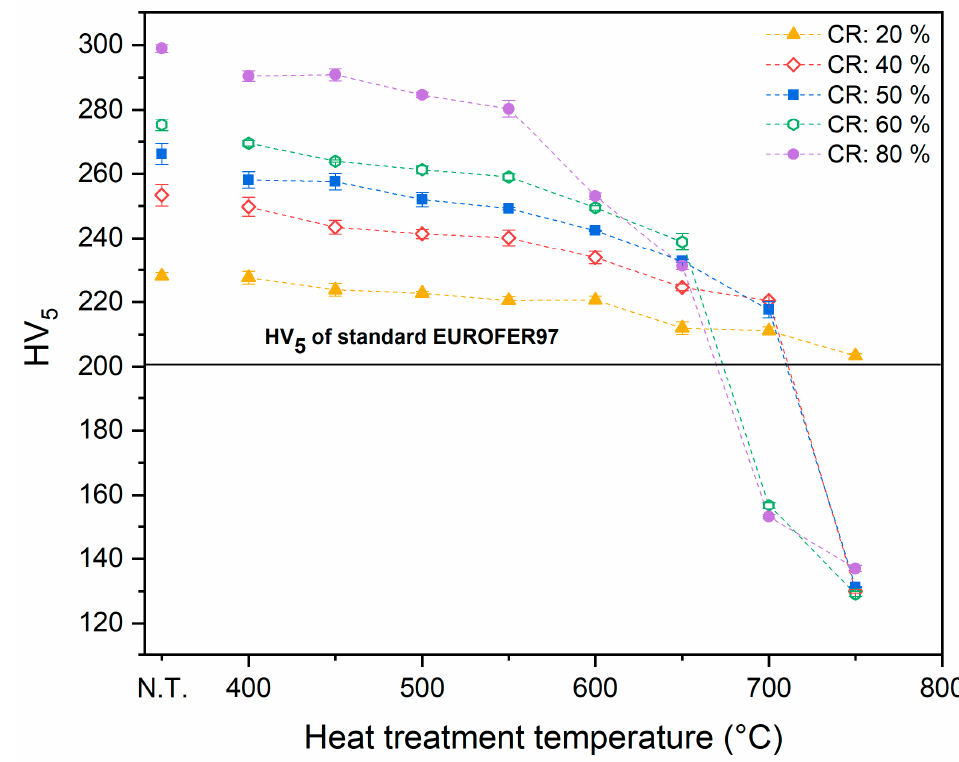
Figure 12. Effect of the CR ratio and the heat treatment temperature on hardness of EUROFER97 steel. Heat treatment was performed for 1 h in argon atmosphere. Table 4. Softening percentage of EUROFER97 steel, in the temperature range of the annealing heat treatment from 400 °C to 750 °C.